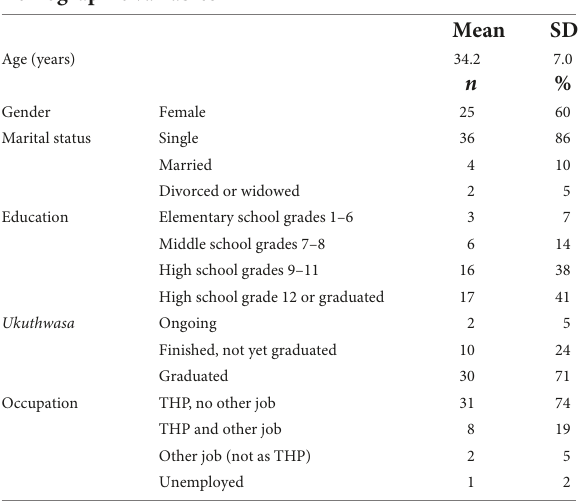
TABLE 1 Sociodemographic characteristics of the amathwasa ( n = 42). Demographic